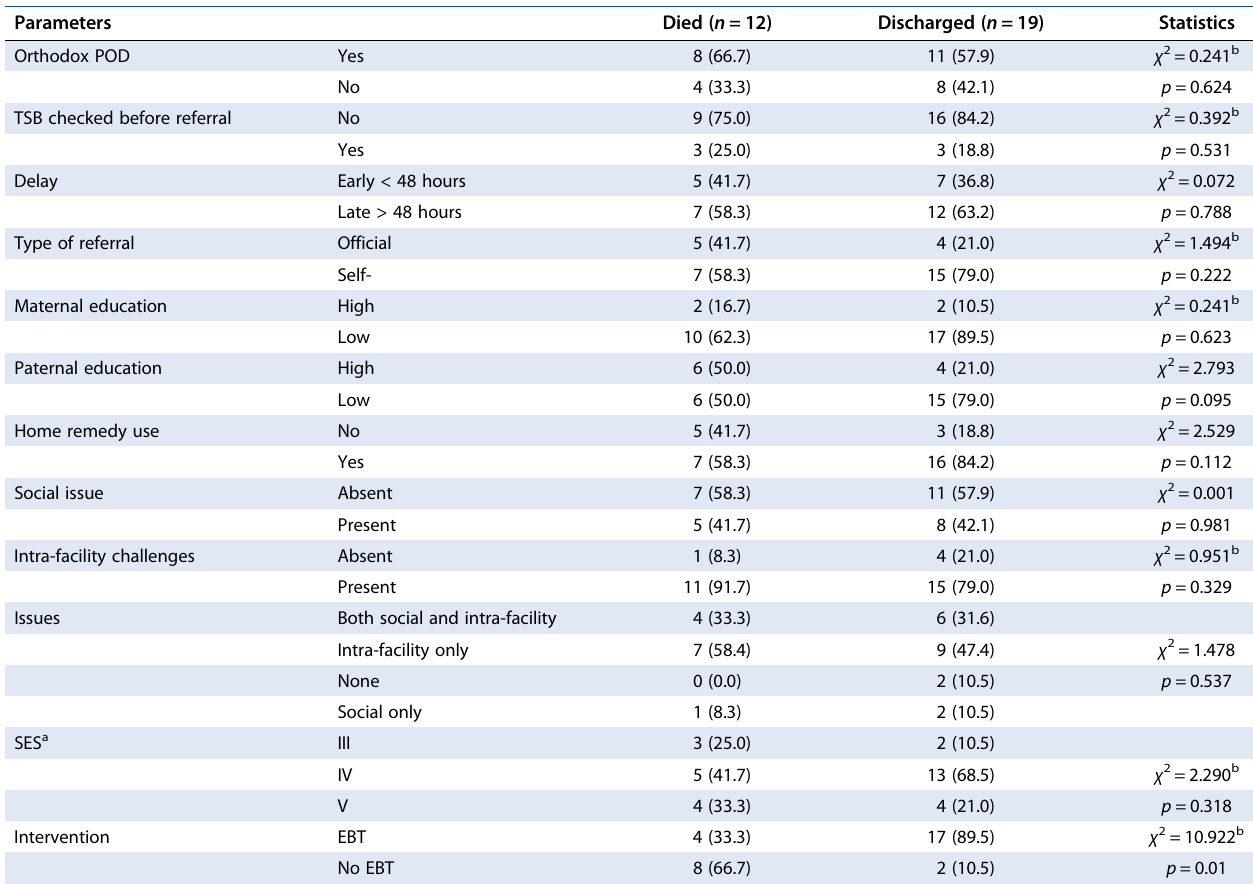
Table 2: Factors associated with immediate outcome of 31 babies with ABE*